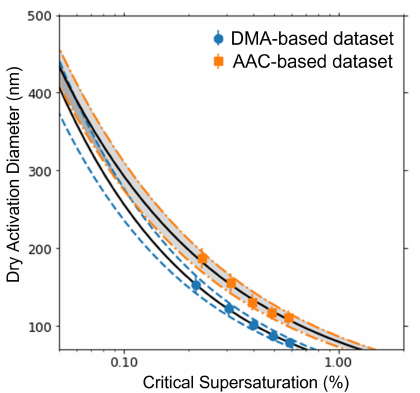
Figure 7. The variation in uncertainty of size-resolved measure- ments using a DMA and AAC are compared in this plot. The orange dot-dashed lines denote the range of uncertainty in measurements in an AAC, and the blue dashed lines denote the range of uncertainty in measurements in a DMA. The black solid lines are the best fits for the size-resolved measurements for sucrose obtained using the Köhler